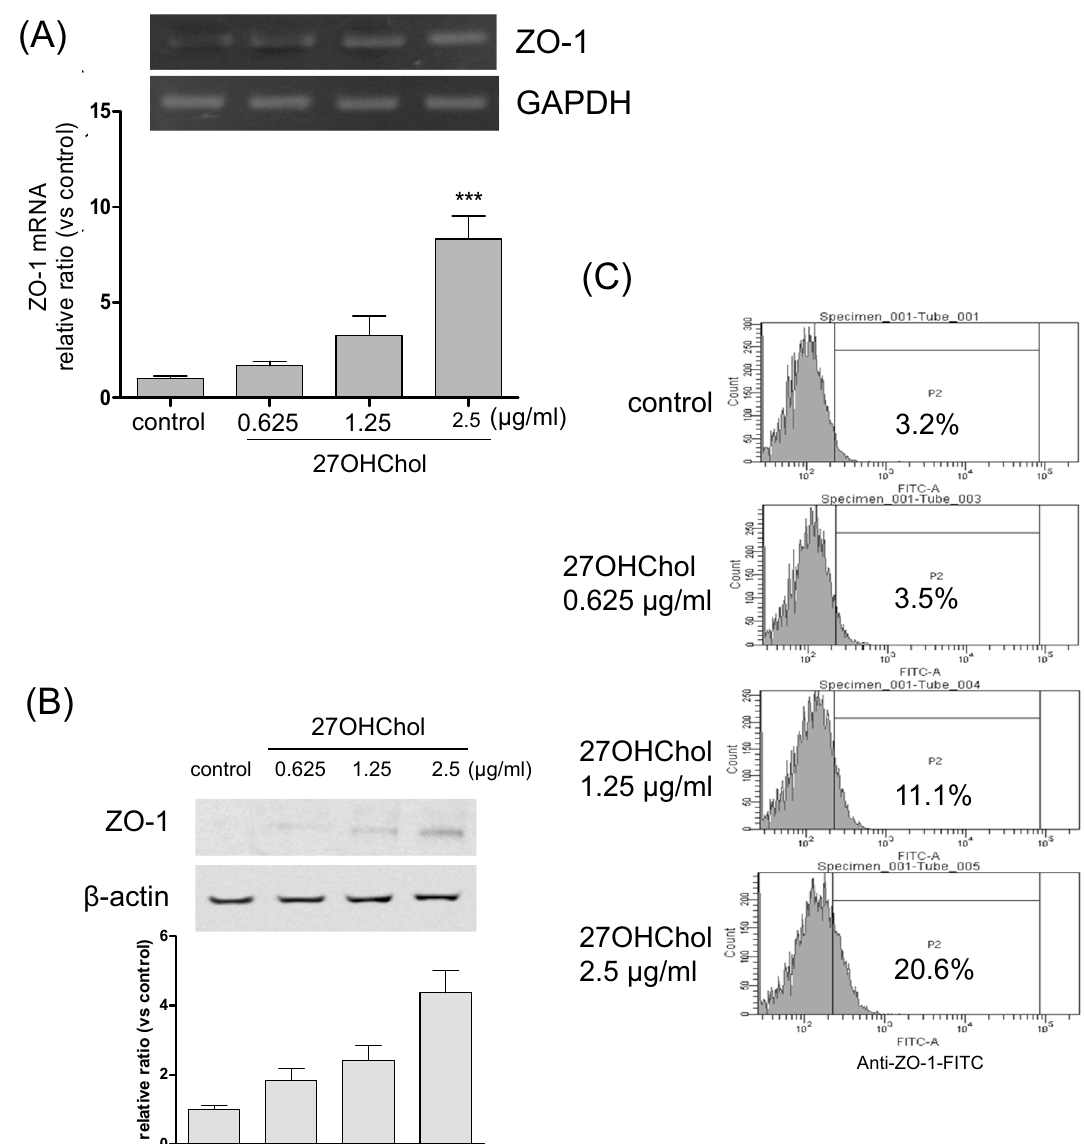
Figure 2. Effects of 27OHChol concentrations on the ZO-1 expression. Monocytic cells were stimulated with the indicated concentrations of 27OHChol for 48 h. ( A ) The transcript levels of the ZO-1 gene were analyzed using quantitative RT-PCR and real-time PCR. The data are expressed as the mean ± SD (n = 3 replicates/group). *** P < 0.01 versus control. ( B ) The proteins harvested from the cells were analyzed by Western blot to detect ZO-1. ( C ) The cells were immunostained with antibodies against ZO-1 and analyzed by flow cytometry. The results are representative of three independent